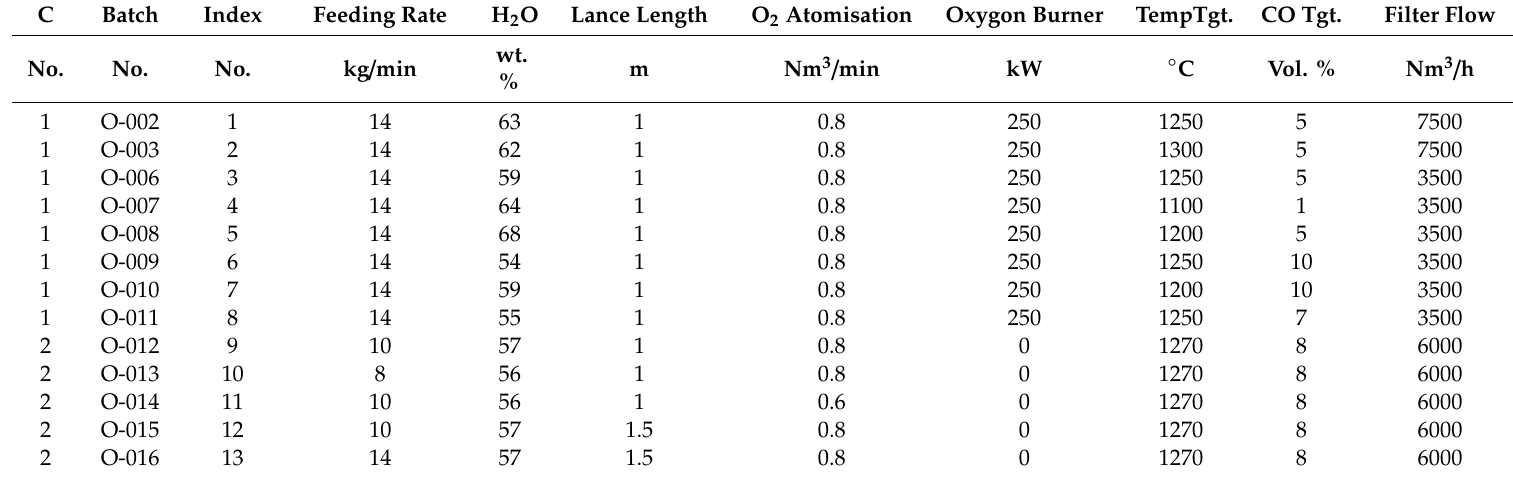
Table 2. Evaluated process parameters in campaigns (C) No. 1 and